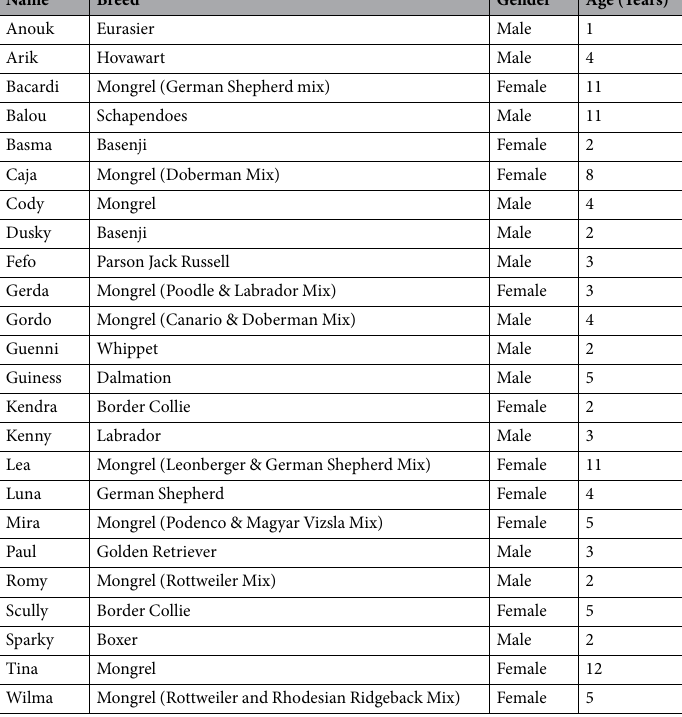
Table 2. List of the dogs included in the study with information about breed, gender and age